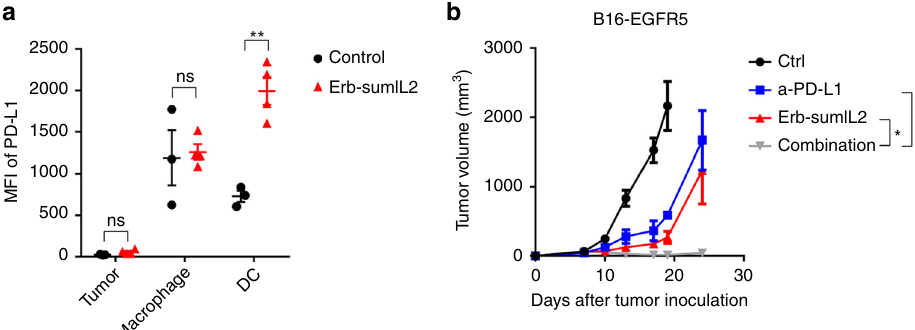
Fig. 7 SumIL-2 therapy overcomes checkpoint blockade resistance. a C57BL/6 mice ( n = 3 – 5/group) were inoculated with 5 × 10 5 B16F10 cells and treated intravenously with 10 μ g of Erb-sumIL2 on day 9. Three days after treatment, tumors were removed and digested into single-cell suspensions. PD-L1 expression on myeloid cells and tumor cells was detected by fl ow cytometry. b WT C57BL/6 mice ( n = 5/group) were injected subcutaneously with 5 × 10 5 of B16F10-EGFR5 cells and i.p. treated with 25 μ g of Erb-sumIL2 or/and i.t. treated with 50 μ g of anti-PD-L1 on days 8, 11, and 14. Two way ANOVA tests were used to analyze the tumor growth data. Unpaired T-tests were used to analyze the other data. ns (not signi fi cant), * P < 0.05, ** P < 0.01, *** P < 0.001, and **** P < 0.0001. One of the two or three representative experiments is